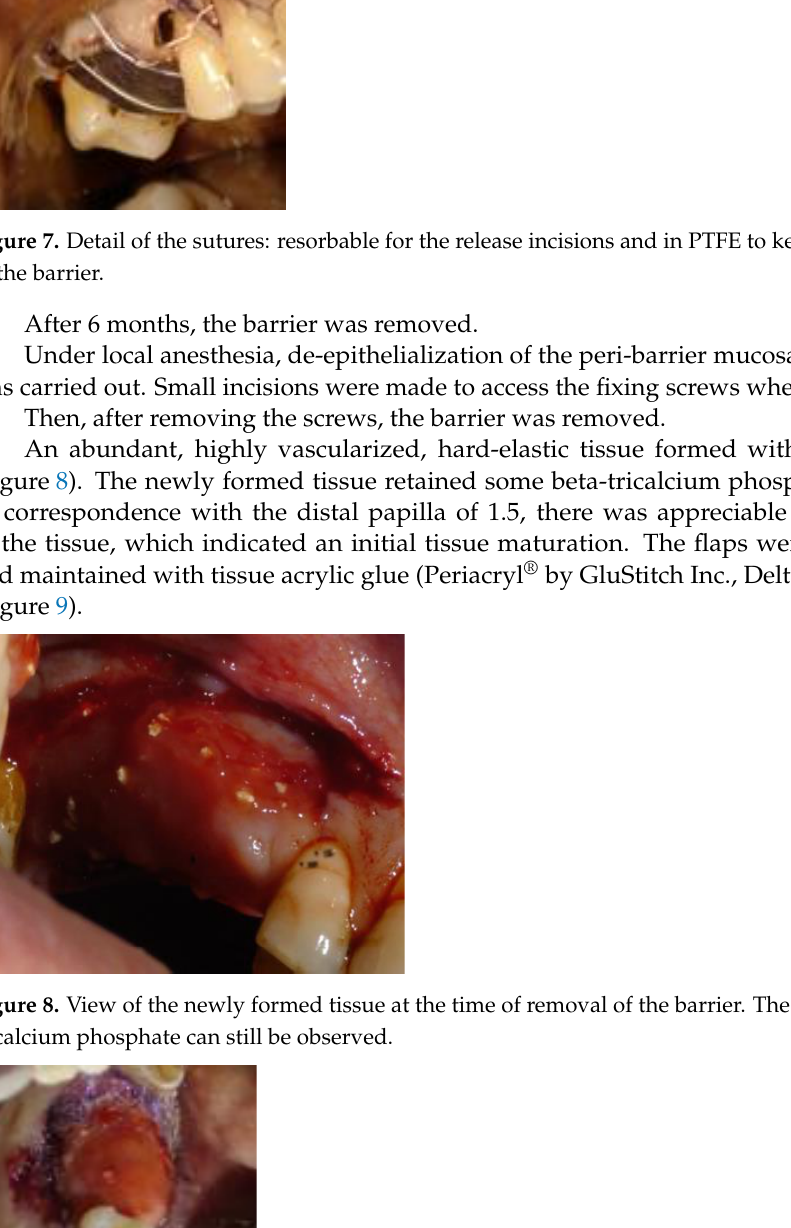
Figure 6. Barrier filled with clot and beta tricalcium phosphate.